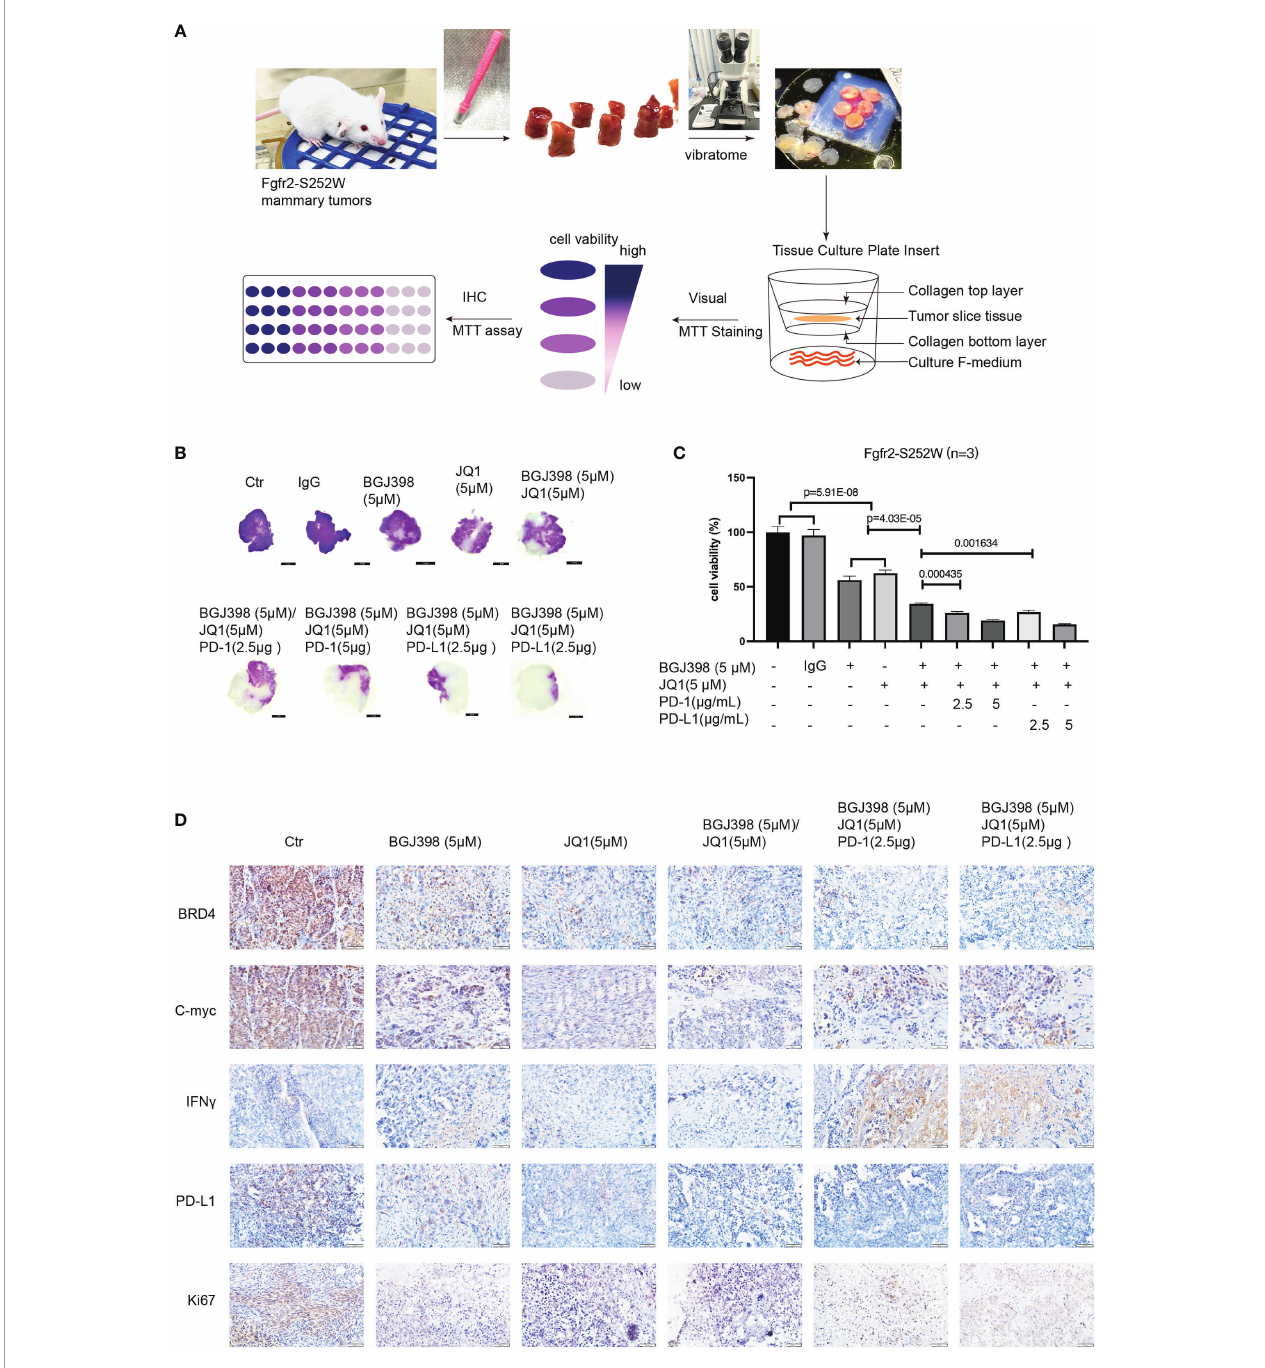
FIGURE 6 | (A) Three-dimensional tissue slice culture work fl ow for quick, reliable models assessing immunotherapy. (B) Visualization of the antitumor response revealed by MTT analysis. (C) MTT assay evaluating the proliferation of Fgfr2-S252W tumor tissues. Data are shown as the mean ± SEM. p-Values by two-tailed Student ’ s t-test. (D) Immunohistochemistry (IHC) staining against BRD4, c-Myc, IFN- g , Ki67, and PD-L1 in the indicated treatment